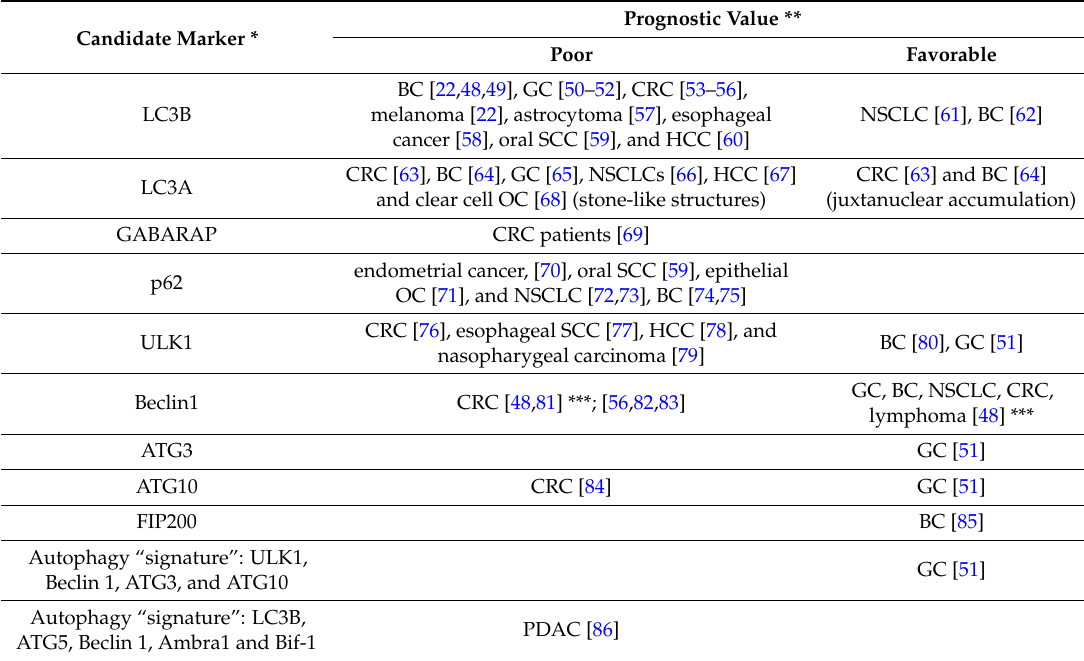
Table 1. Prognostic values of autophagy-related proteins in